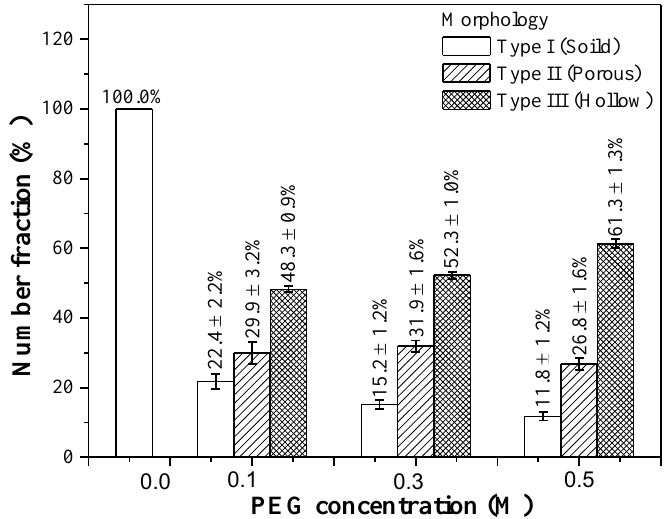
Figure 4. Relative fractions of un-treated 0.1 M, 0.3 M, and 0.5 M PEG-treated BG particles with three distinct morphological types of solid, porous, and hollow structures.